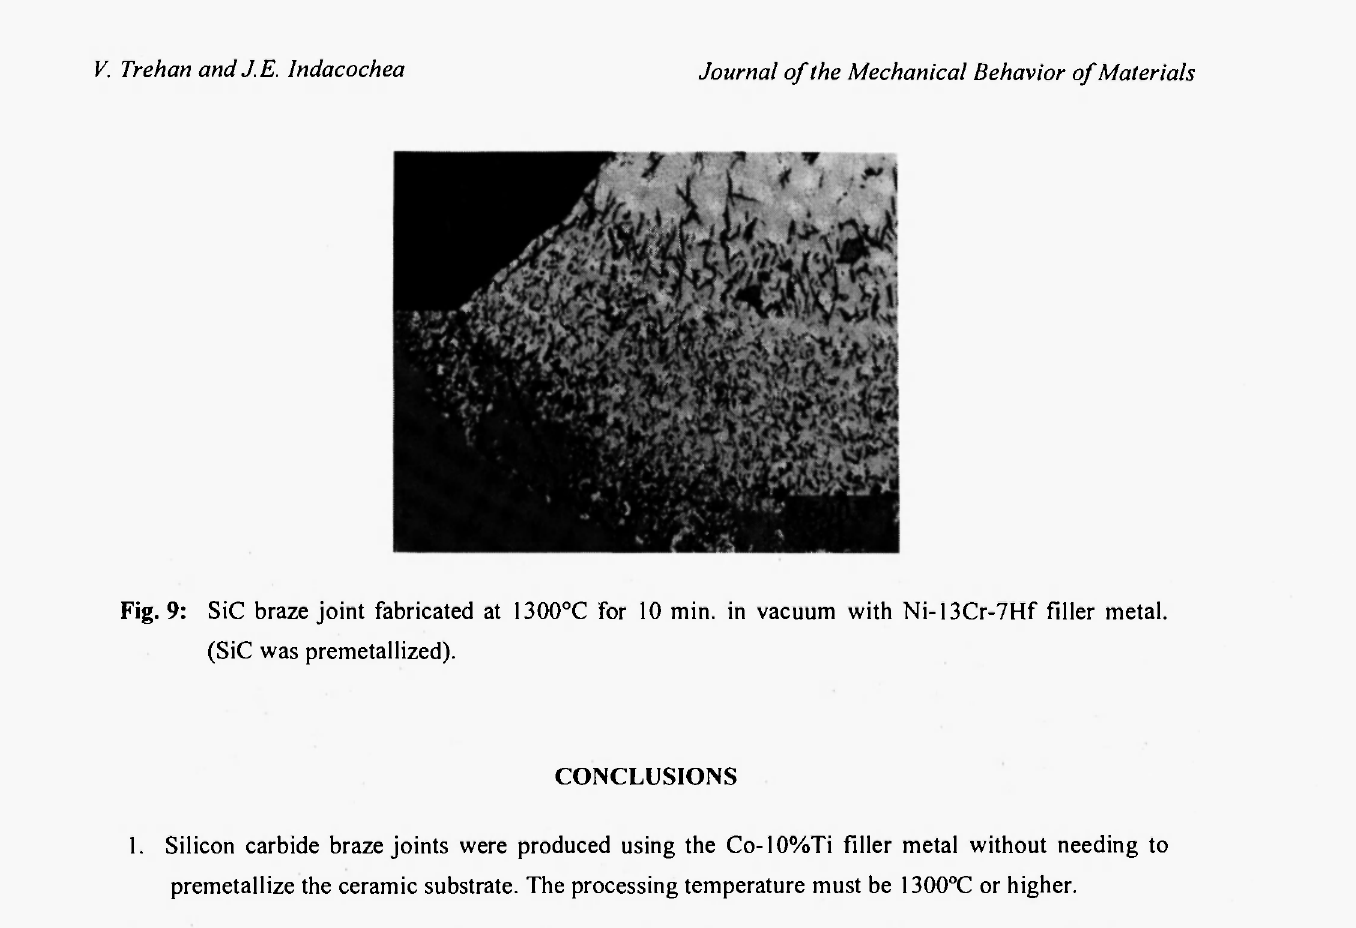
Fig. 9: SiC braze joint fabricated at 1300°C for 10 min. in vacuum with Ni-13Cr-7Hf filler metal. (SiC was